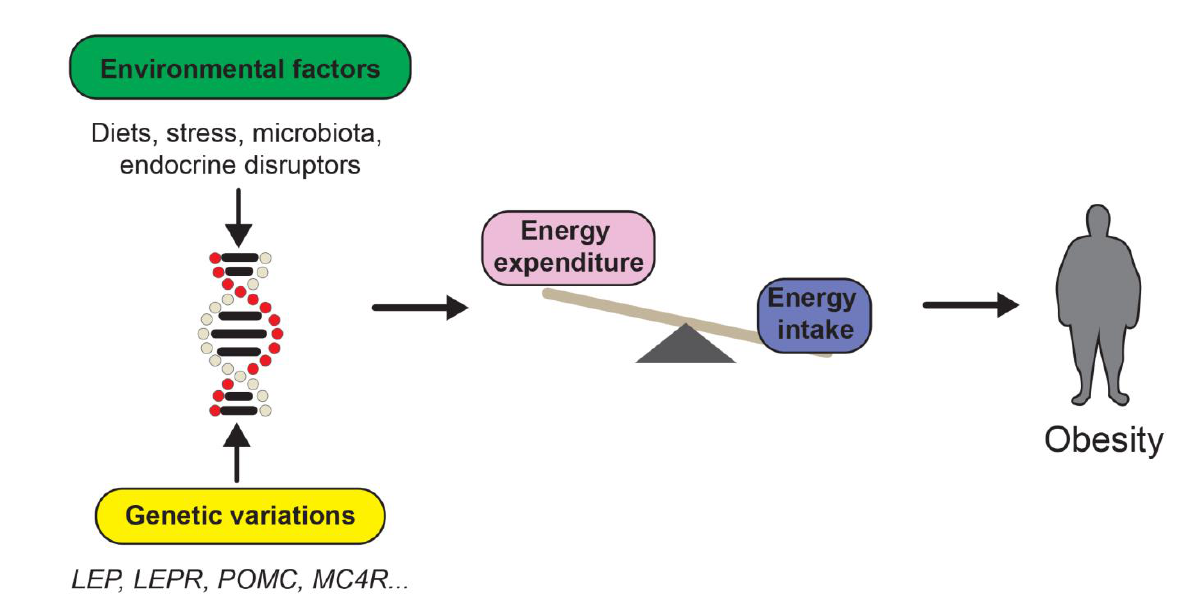
FIGURE 1: Obesity is at the interplay between genetic and environmental factors. The development of obesity is influenced by genetic and environmental factors. The study of monogenic obesity has led the discovery of several obesity susceptibility genes such as Proop- imelanocortin (POMC), Melanocortin receptor 4 ( MC4R ) or Leptin ( LEP ) among others. However, diverse environmental factors such as the diet, combined with genetic variations, also influence energy balance